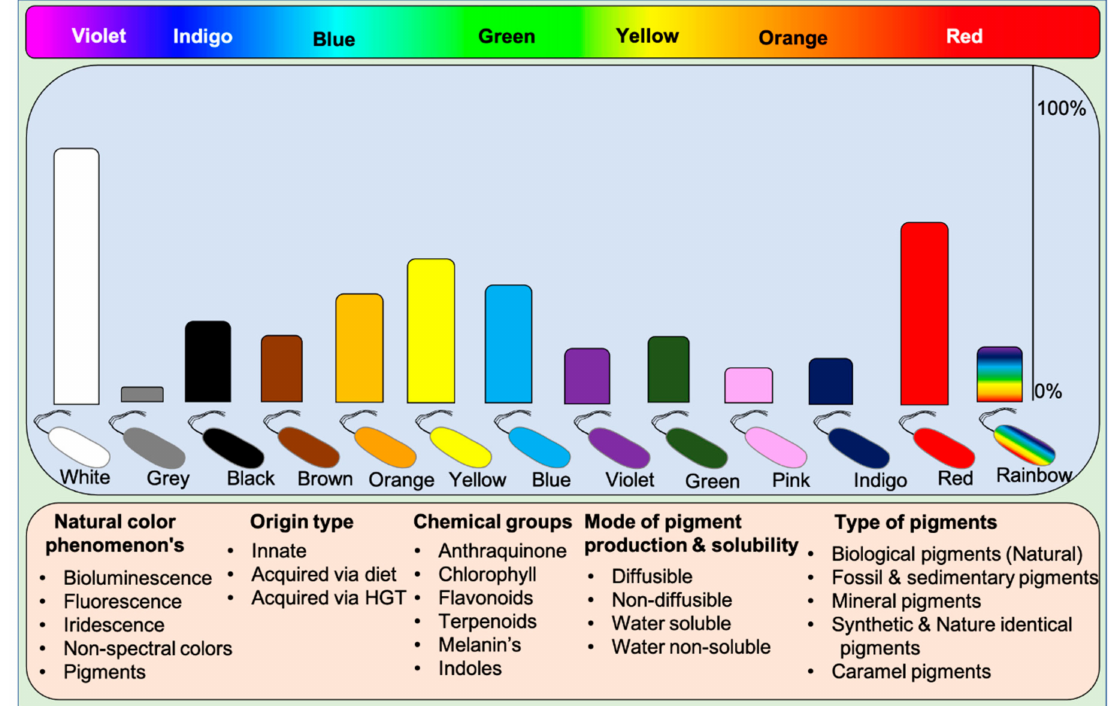
Figure 1. A wide array of pigmented microbes seen in nature. The abundance of the type of pigmented bacteria is depicted in bars based on the available literature. Rainbow bacteria are iridescent. Classification of pigments based on various aspects of biochromes. Chlorophyll pigments are not included in the data as they are ubiquitous. HGT: Horizontal gene